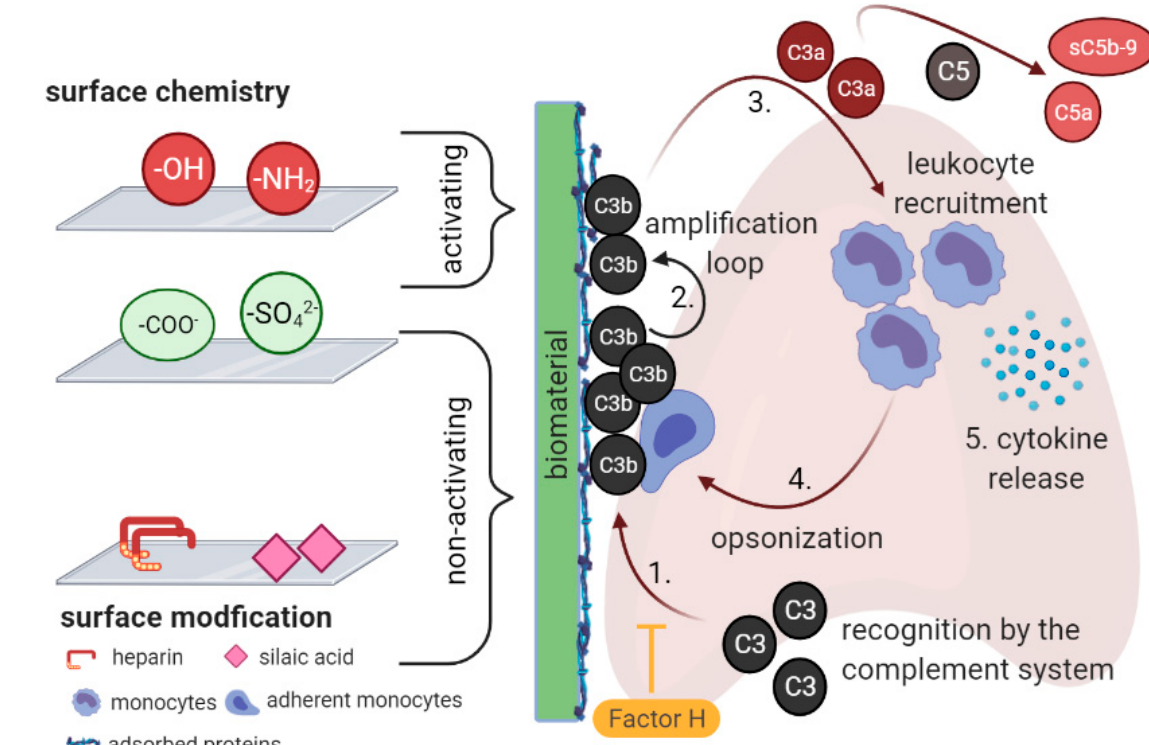
Figure 1. Complement activation by biomaterials through the alternative pathway. After first contact with blood, plasma proteins quickly adsorb to the biomaterial surface. The composition of the adsorbed protein layer subsequently triggers complement activation by covalent binding of C3b (1.), which activates the amplification loop, generating more C3b fragments from circulating C3 (2.). Eventually, the C3b fragments conceal the protein layer, which enhances the release of C3a, C5a, and sC5b-9 into the fluid phase. These fragments are potent chemoattractants that recruit monocytes to the biomaterial surface (3.). Active monocytes recognize surface bound C3b through CD11b/CD18 (Mac-1) and initiate opsonization (4.) and cytokine release (5.). Factor H is a major soluble inhibitor of complement activation and negatively charged surfaces accelerate its binding to immobilized C3b, thus providing a non-activating surface. Created with Bio- Render.com.